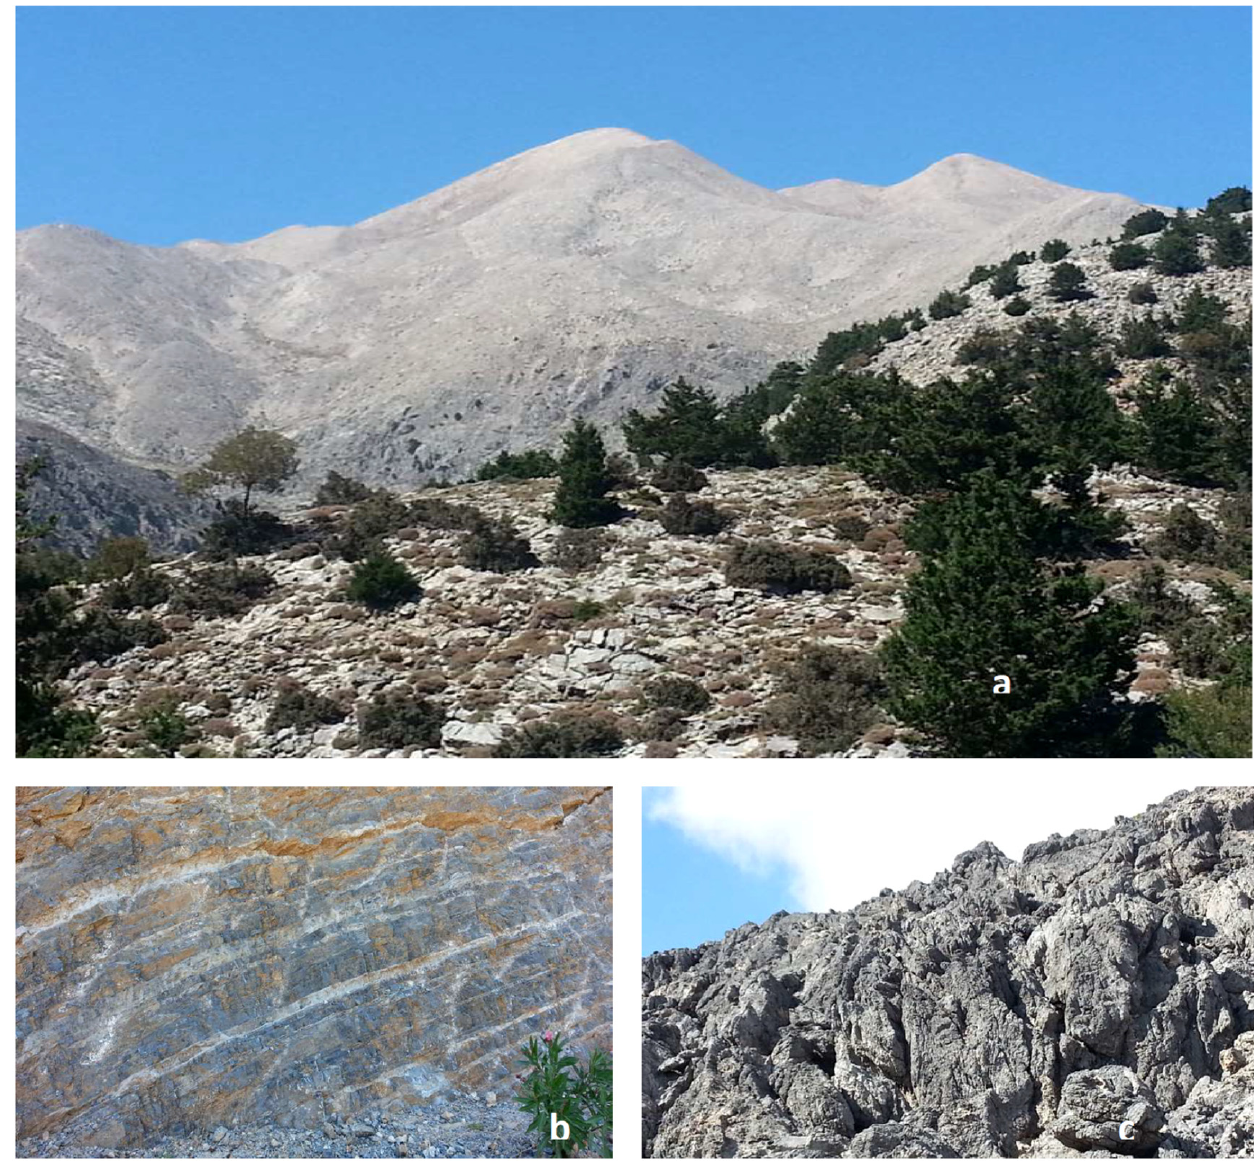
Figure 8. “Lefka Ori” Mountains: ( a ) Landscape; it consists of carbonate rocks ( b ) “Plattenkalk unit”; well bedded, gray-bluelimestone (marbles) including thin intercalations of white cherts, and ( c ) “Trypalion unit”; unbedded and strong tectonized limestone and dolomite. These geological features in combination with the high precipitation, contribute to the intense karst development (photos by Aik. P. Pavlaki). The “Plattenkalk unit” (Pk, Triassic–Eocene; Figure 8b) appears to be formed by the development of well bedded, gray-blue recrystallized limestones (marbles), including white or black cherts, under the form of thin intercalations and bulbs [21,45]. Typical appearances of the above layers can be found in the southern part of the Samaria gorge, as well as in the Imbros gorge. The upper layers progressively have been evolved to thick-bedded marbles with intercalations of ash-greenish calcitic phyllite, passing on the top in a flysch. Flysch, as was identified by References [18,46] and named “Lefka Ori—Plattenkalk metaflysch”, consists of slight metamorphism’s calcareous and chloritic phyllite and is characterized by thin developments and rare